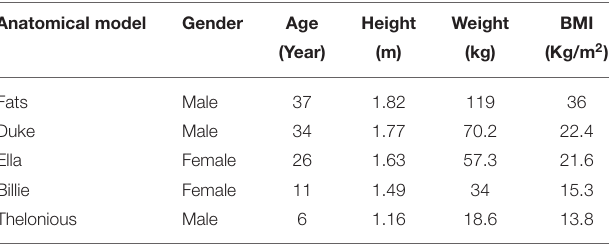
TABLE 2 | Geometry of the radio frequency (RF) birdcage coil considered in the